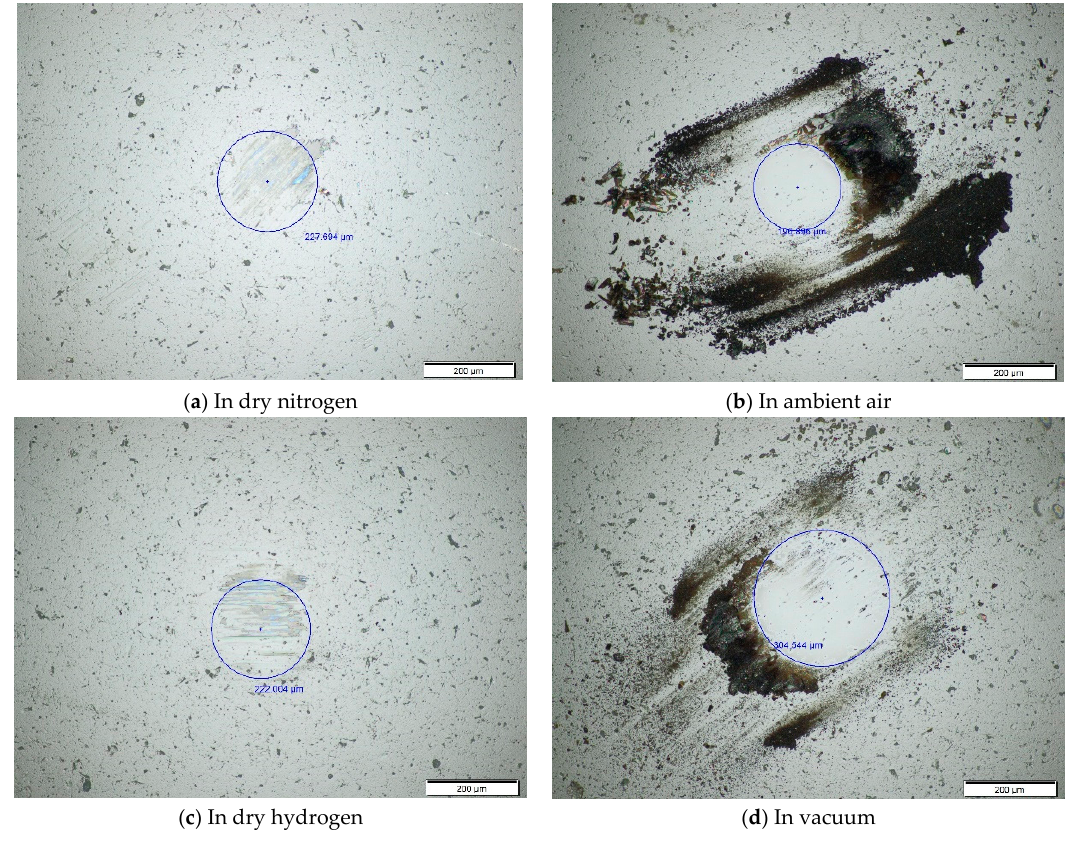
Figure 7. Worn surface images of ball under different environments at 200 °C: ( a ) in dry nitrogen, ( b ) in ambient air, ( c ) in dry hydrogen, ( d ) in vacuum and there is the worn zone within circle.